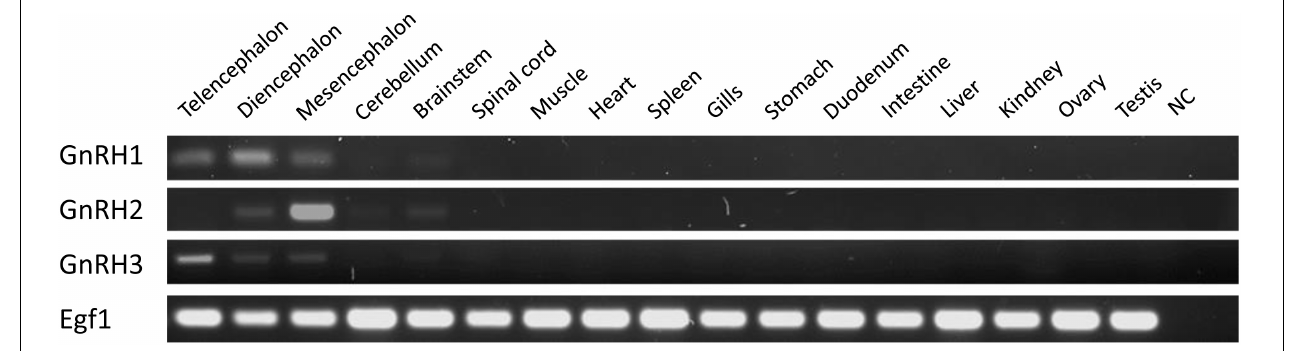
FIGURE 7 | Tissue distribution of catshark GnRH1 , GnRH2, and GnRH3 mRNAs using RT-PCR. Parallel amplification of dogfish Egf1 mRNA served as internal control. NC, non-template